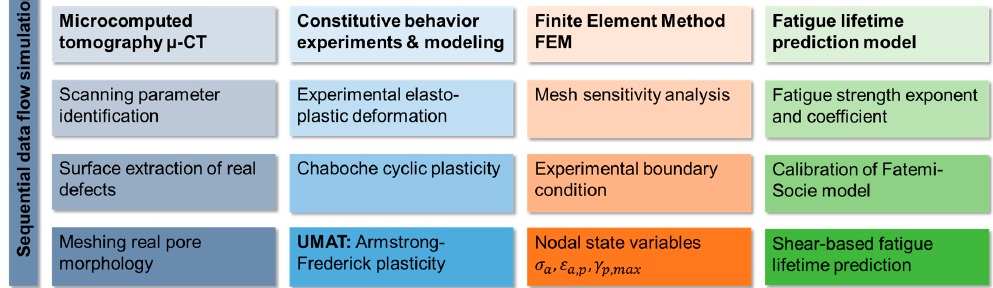
Figure 1. Flow chart of the applied simulation scheme on the macro-mesoscale.